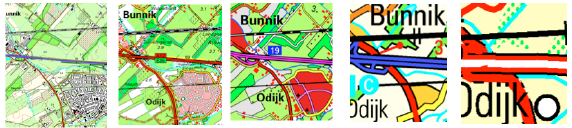
Figure 5. Map series of Netherlands’ Kadaster (1:10k, 1:50k, 1:100k, 1:250k,